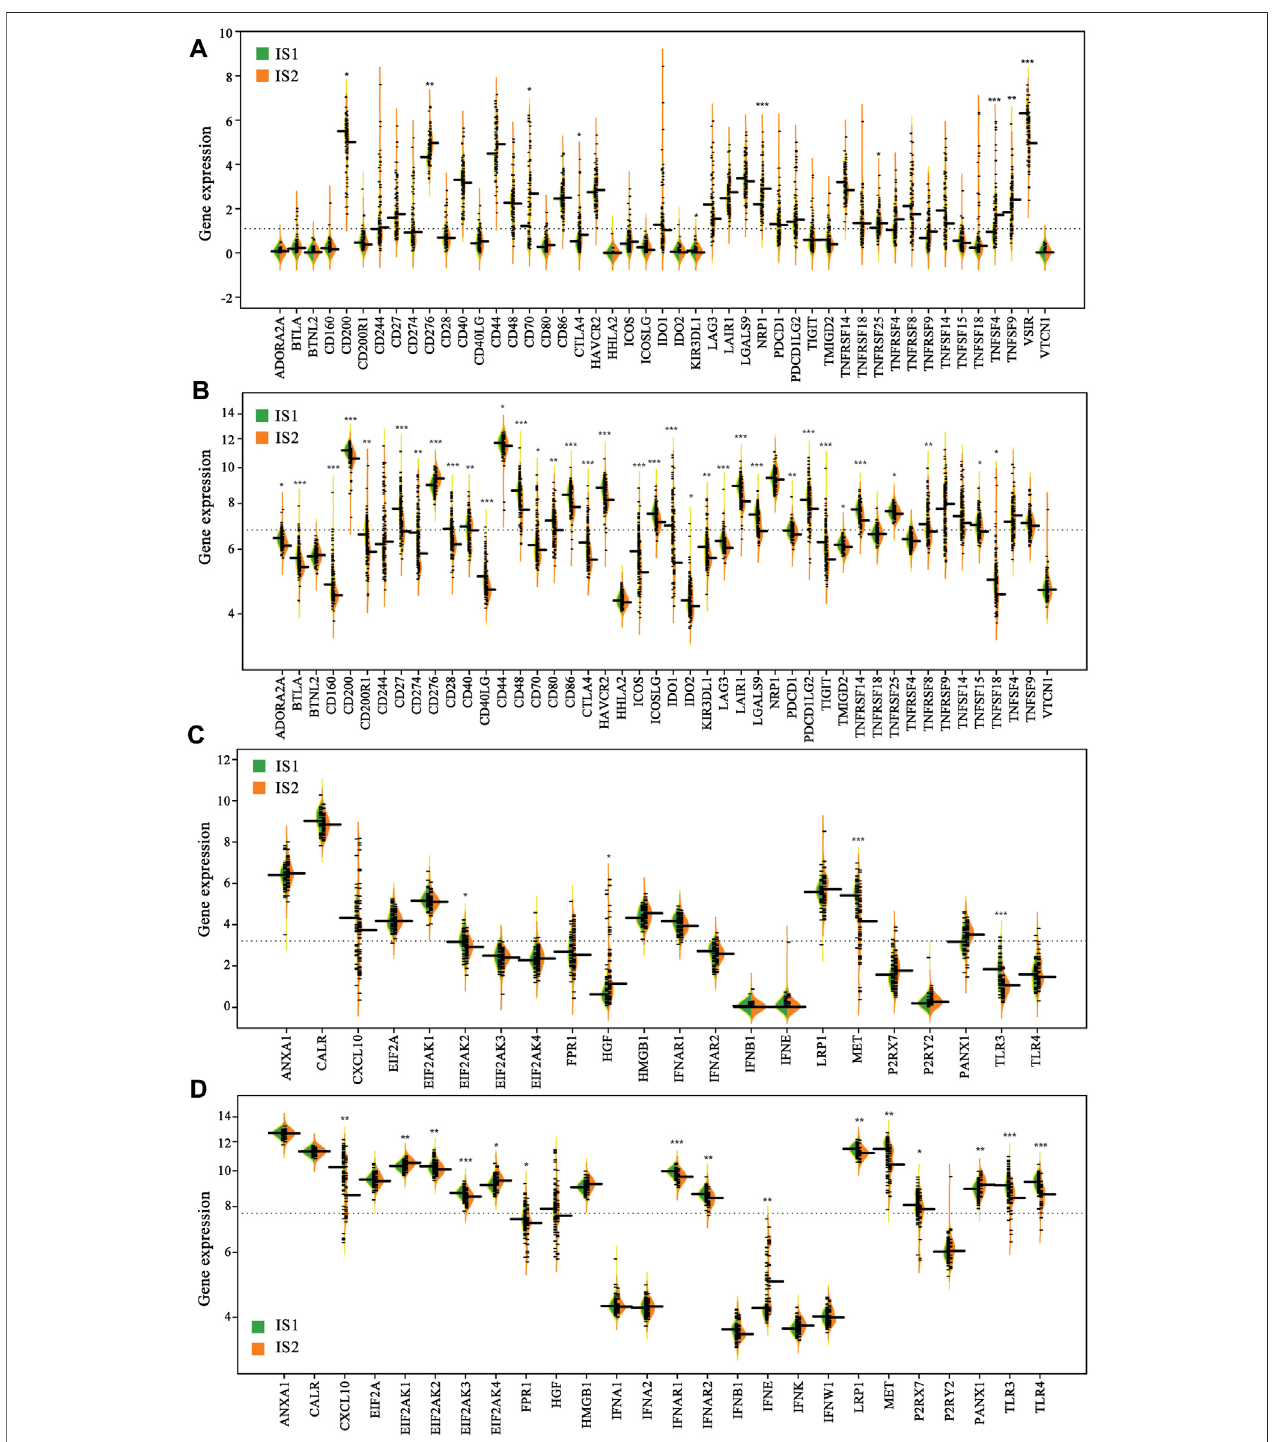
FIGURE6| Difference intheexpressionofimmune checkpoints (ICPs) andimmunogeniccelldeath(ICD)modulators ofthetwoimmunesubtypes (A) ICPs(TCGA cohort) (B) ICPs (GEO cohort) (C) ICPs (TCGA cohort) (D) ICPs (GEO cohort) (* p < 0.01, ** p < 0.001, and, *** p < 0.0001).